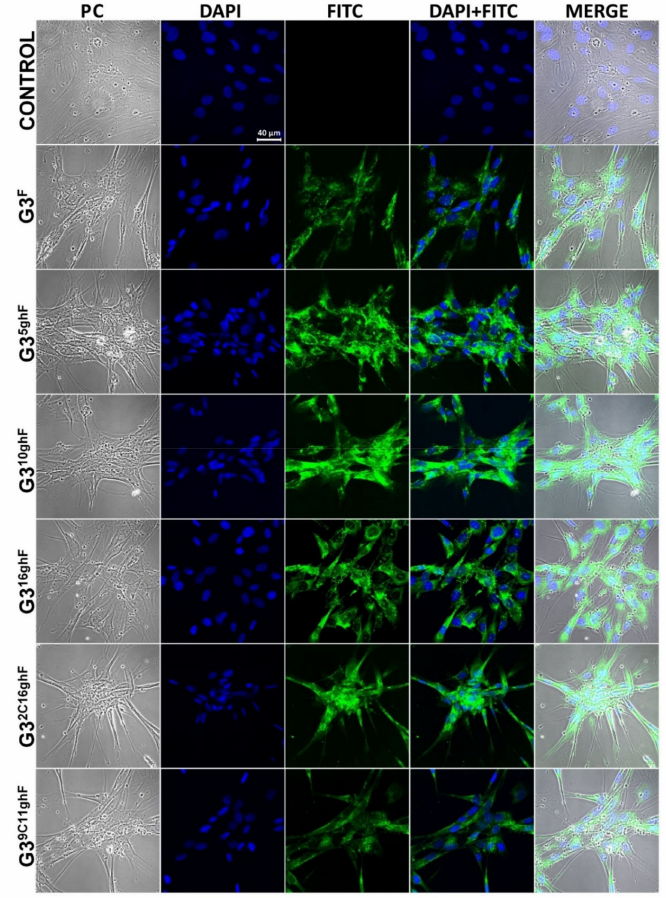
Figure12. Confocalmicroscopyimagespresentinglevelofconjugatesaccumulationafter24hincubation with 1 µ M compounds concentration: Green signal is the fluorescein isothiocyanate (FITC)-labelled conjugates; blue signal is the nuclei stained with 600 nM DAPI (4 (cid:48) ,6-diamidino-2-phenylindole, dihydrochloride) dye; and PC is phase contrast. Scale bar equals 40 µ